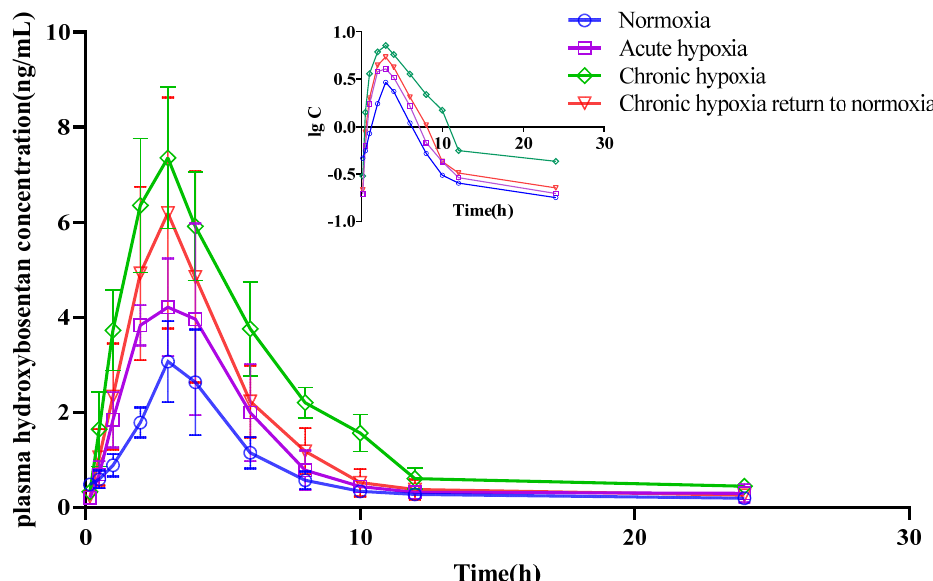
Figure 11. Mean plasma concentration time curve of hydroxybosentan for rats after exposure to high-altitude hypoxia ( n = 8).